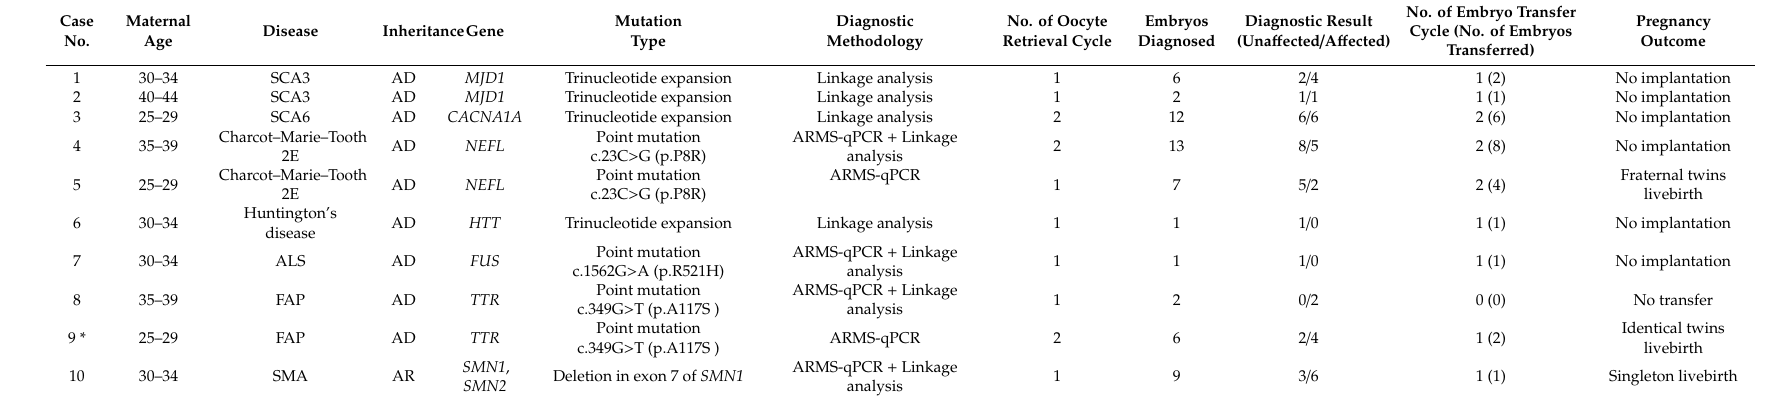
Table 3. PGD of neurodegenerative diseases in our